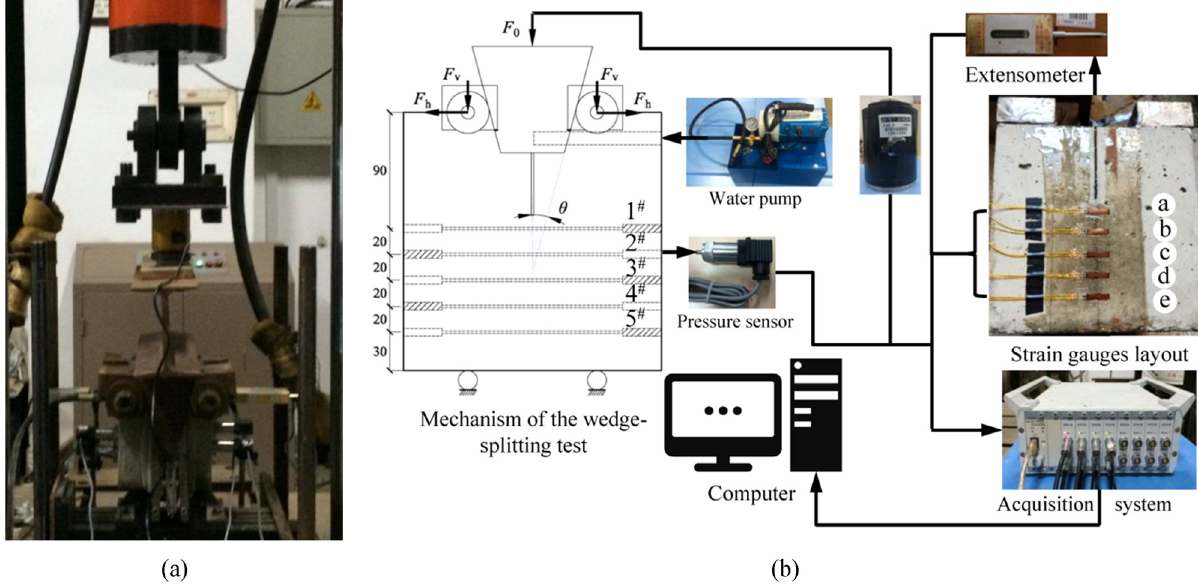
Figure 2: Hydraulic fracture test with the mechanical wedge - splitting device. ( a ) Test set - up and ( b ) wedge - splitting test instrumentation